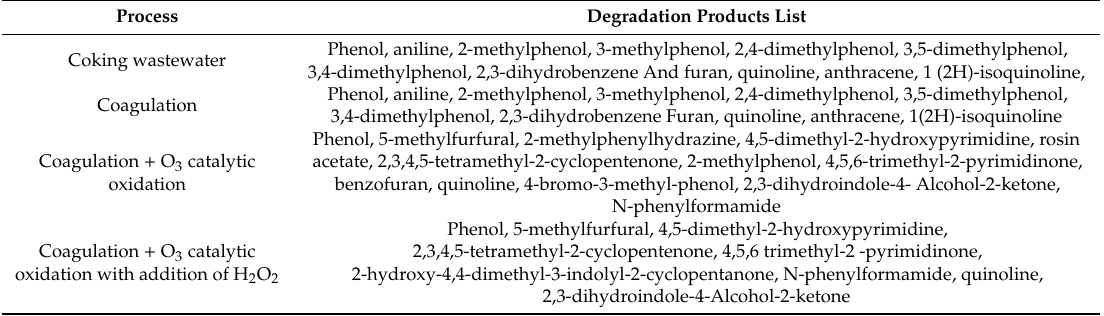
Table 2. Degradation products list of coking wastewater by Ozone catalytic oxidation